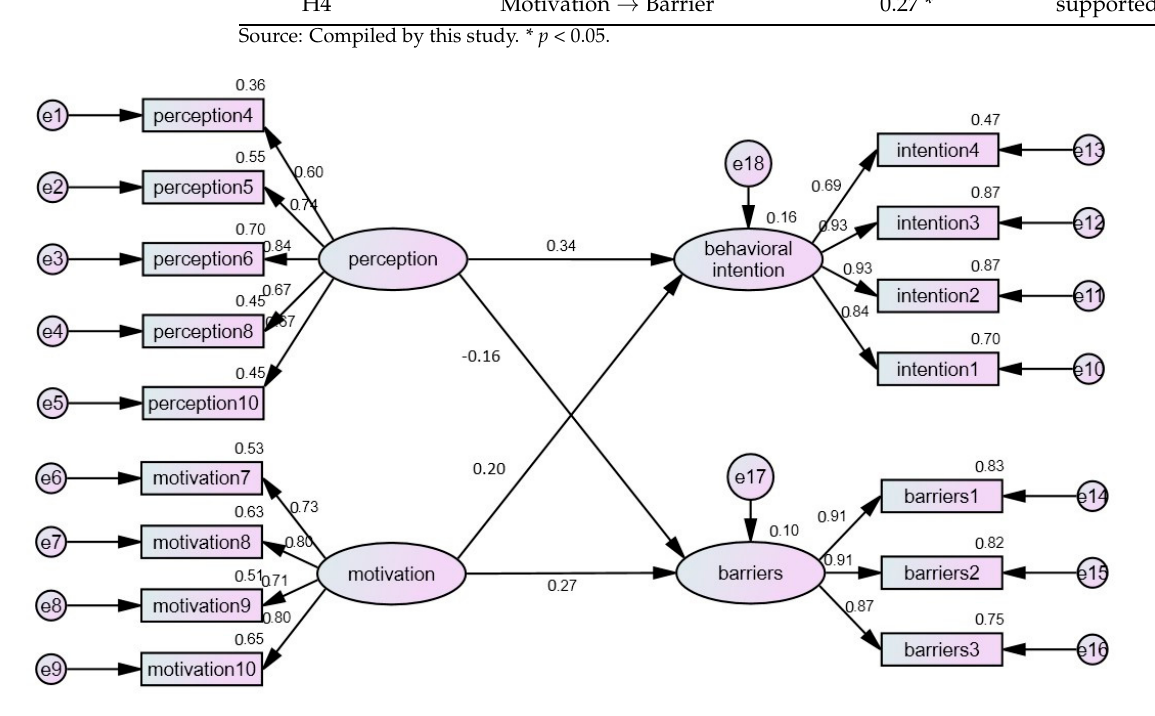
Figure 2. Model of behavioral intention and influencing factors for medical staff to get vaccinated against COVID-19. Table 8. Empirical results of the research